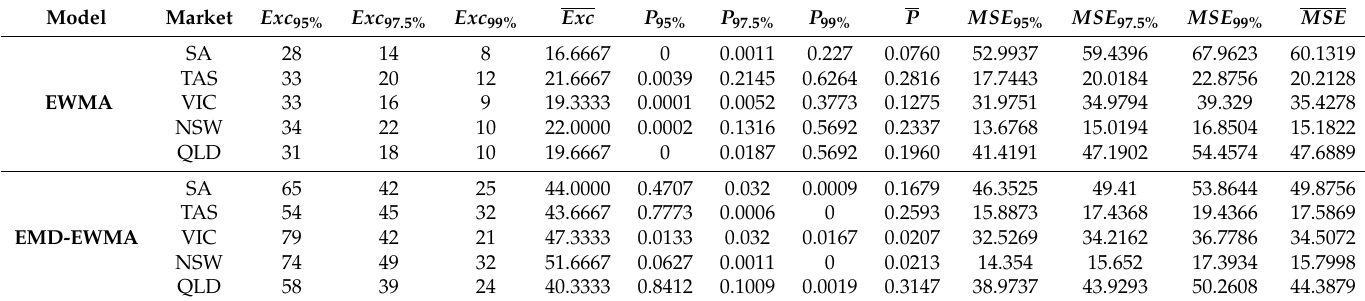
Table 2. Out-of-sample exceedances of different models under standard normal distribution.